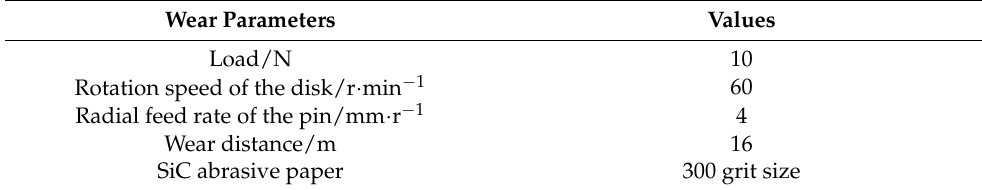
Figure 5. Schematic diagram of abrasive wear test. Table 2. The wear parameters of as-sprayedWC-17Co